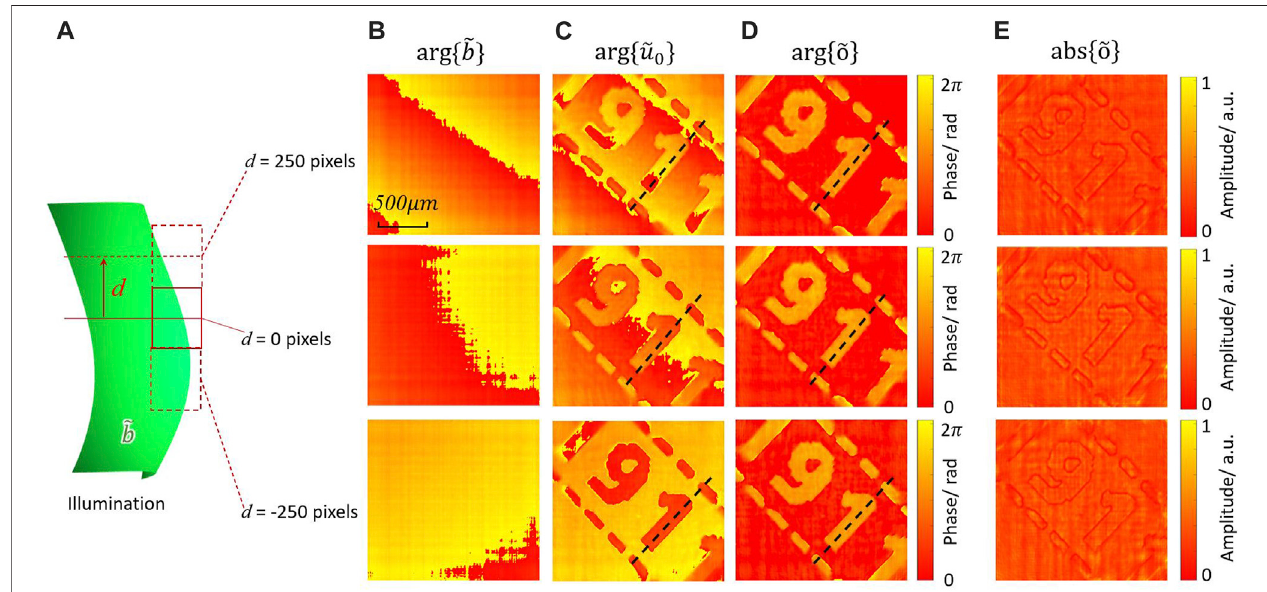
FIGURE8| Measuringthephaseobjectusingthreesectionsoftheillumination. (A) Schematicoftheilluminationintheexperiment. (B) Thereconstructedphaseof differentsectionsoftheillumination. (C) Reconstructedobjectphasewithoutbackgroundsubtraction. (D) Reconstructedobjectphasewithbackgroundsubtraction. (E) Reconstructed object amplitude with background subtraction.